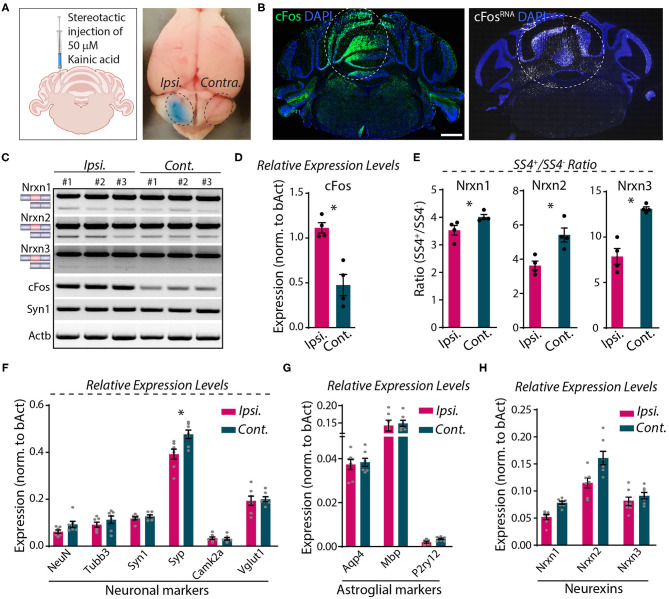
Focal injection of KA in cerebral hemisphere induces Nrxn SS4 alternative splicing. (A) Schematic of experimental paradigm. Fifty millimolars of KA stereotactically injected to ipsilateral cerebellum. Dotted area indicates KA-injected area with bromophenol blue dye and uninjected contralateral side. (B) Induction of cFos expression at protein (left) and RNA (right) levels in the injected area (dotted lines). (C) RT-PCR shows Nrxn SS4 splicing and cFos and Syn1 expression levels in ipsi and contralateral mRNA from three mice. (D) Quantification of relative expression levels of cFos shows significant induction in ipsilateral mRNA (* = p 0.0286). (E) Quantification of Nrxn SS4 splicing ratio shows difference in ipsilateral compared to contralateral side (* = p 0.0286). (F,G) Quantification of relative expression levels of key neuronal markers show no major change in ipsilateral compared to contralateral side, except a reduction in Syp expression (* = p 0.0175). (F). No change in relative expression levels of astroglial markers (G). (H) Quantification of relative expression levels of all Nrxns show general reduction in ipsilateral mRNA. All numerical data are represented as means ± SEM. Statistical significance was calculated by Mann-Whitney non-parametric unpaired t-test. Scale bar 1 mm.